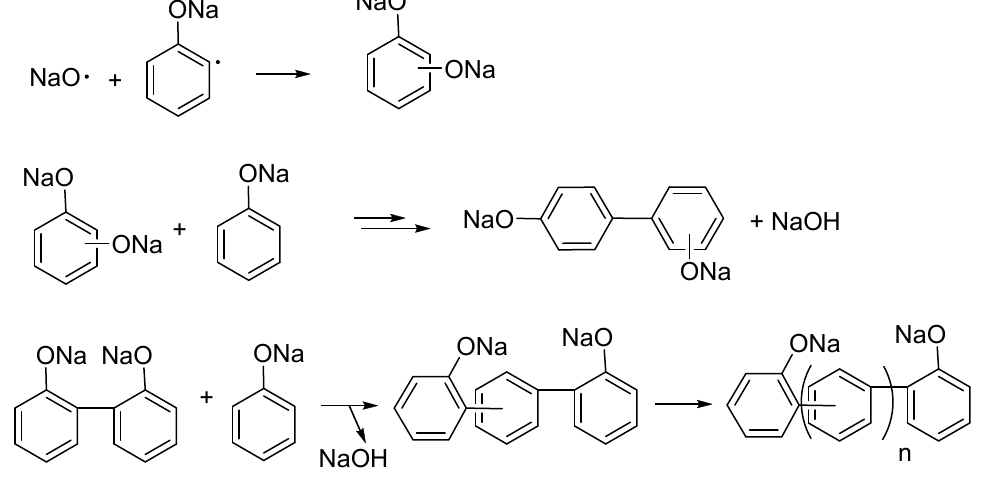
Scheme 2. Hydroarylation and elimination of sodium